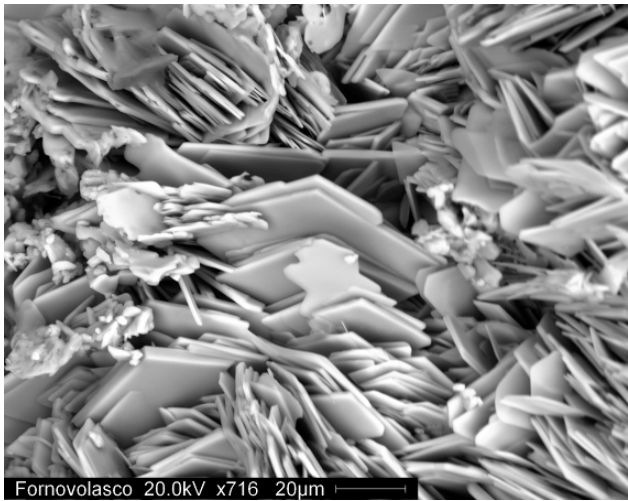
Figure 19. Rhomboclase, rhombic tabular crystals from the Fornovolasco mine.